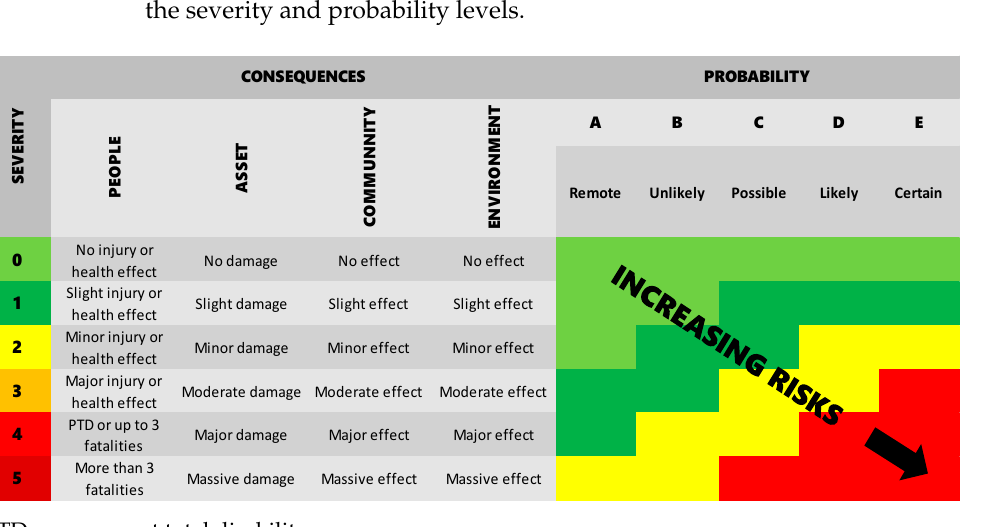
Figure 2. Risk assessment matrix.